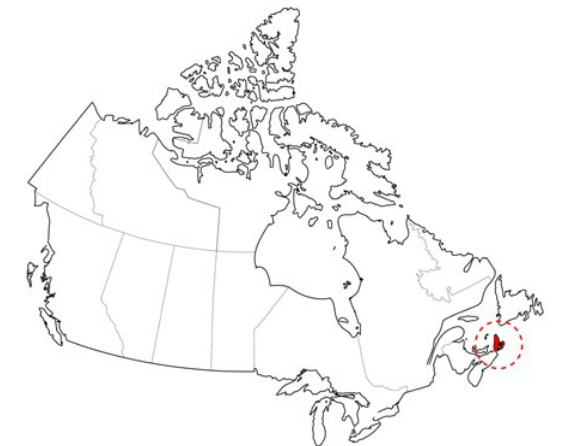
Fig.2 – Beinn Bhreagh at Baddeck, Nova Scotia, Canada In 1885, Alex and Mabel Bell travelled to the Canadian